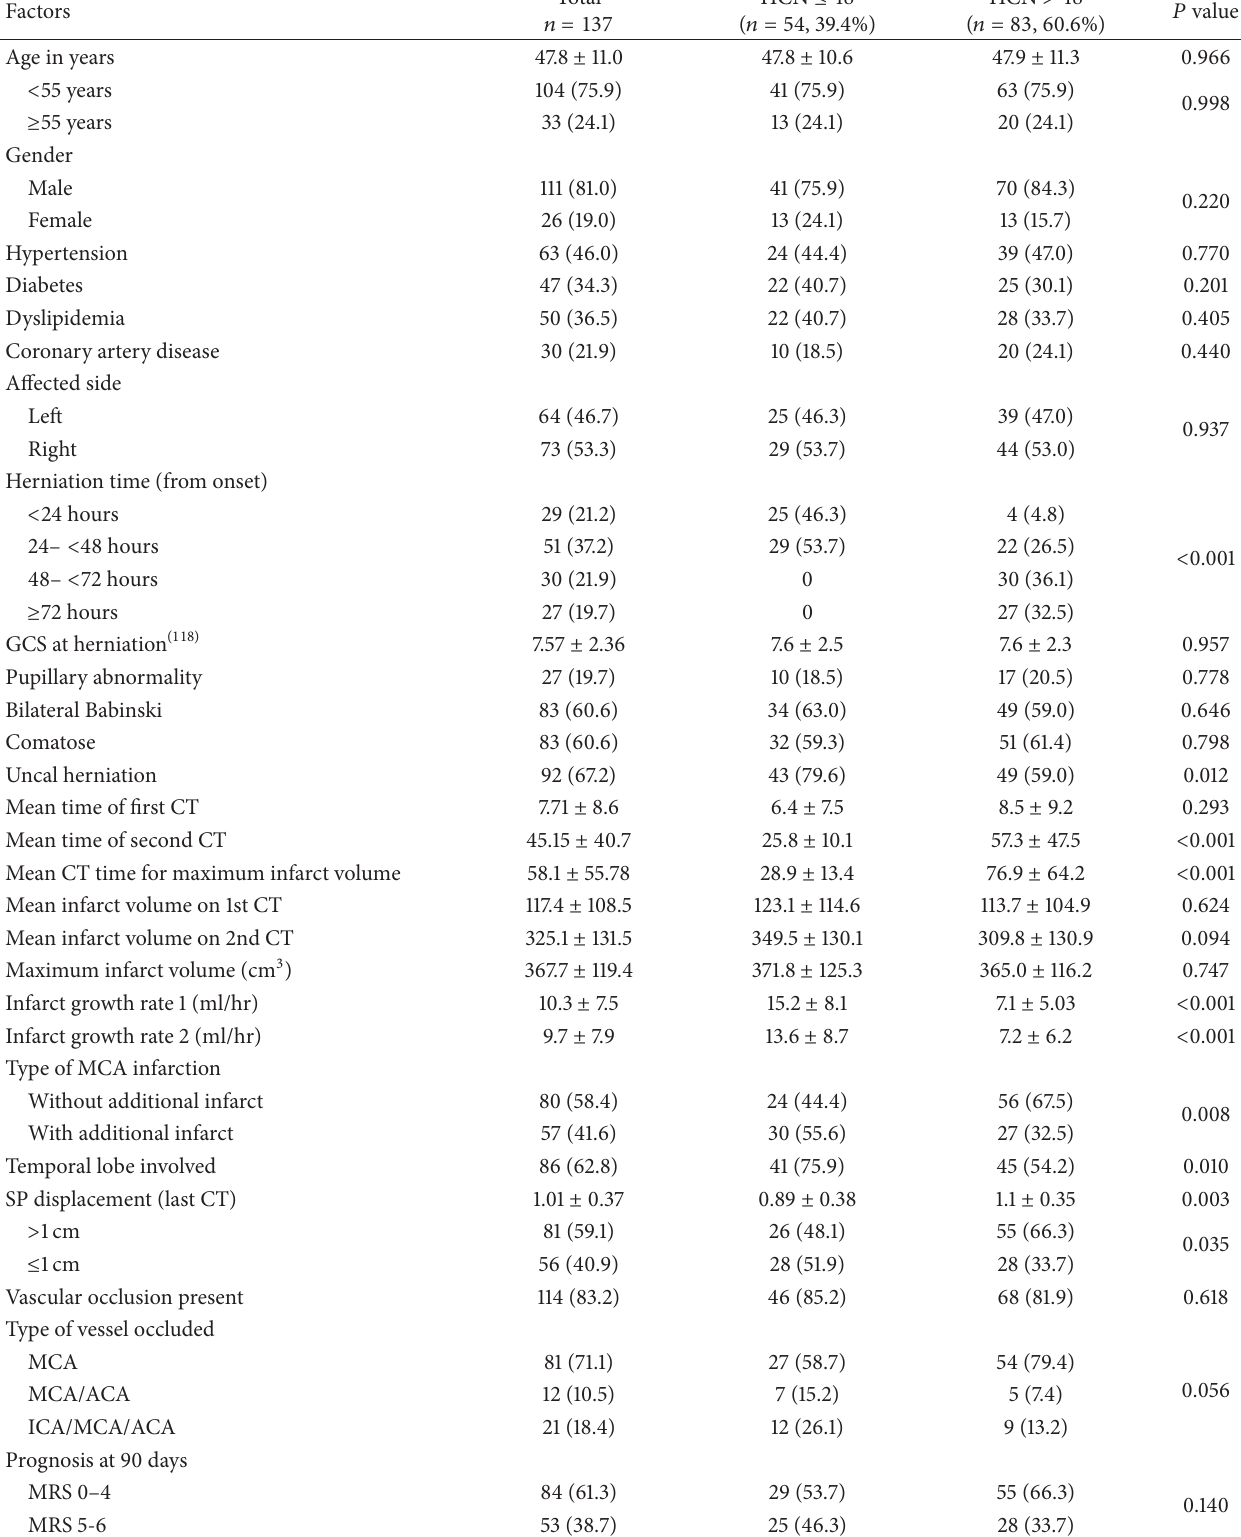
Table 1: Demographic, clinical, radiological imaging, and surgical data in relation to the time of